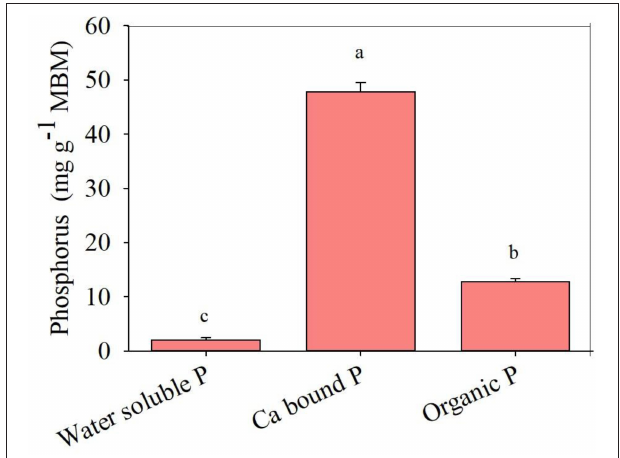
FIGURE 1 | Different mineral forms of phosphorus (P) in MBM. Different alphabetic letters signify the statistical difference (Tukey test, p < 0.05) across the different mineral forms of P. Error bar represents the mean ± SD ( n =